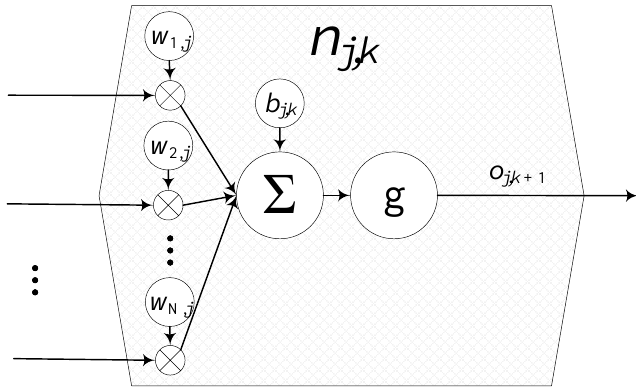
Figure 1. Schematic of a neuron, that can be joined with others to form an artificial neural network.